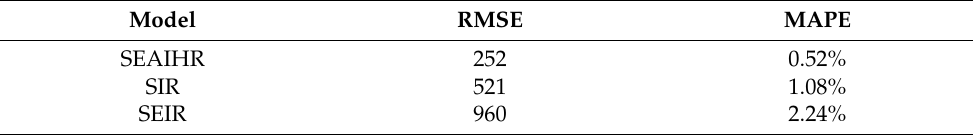
Table 5. Model evaluation in stage 2.